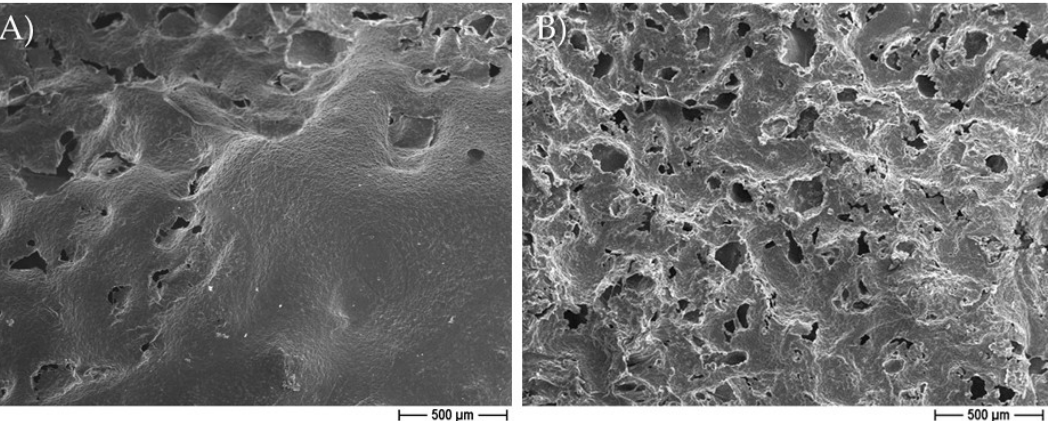
Figure 4. Representative FESEM micrographs of PCL samples obtained by adding 30% eugenol to the polymer using NaCl ( A ) or NaNO 3 ( B ) as pore forming salt, showing the surface microporosities.